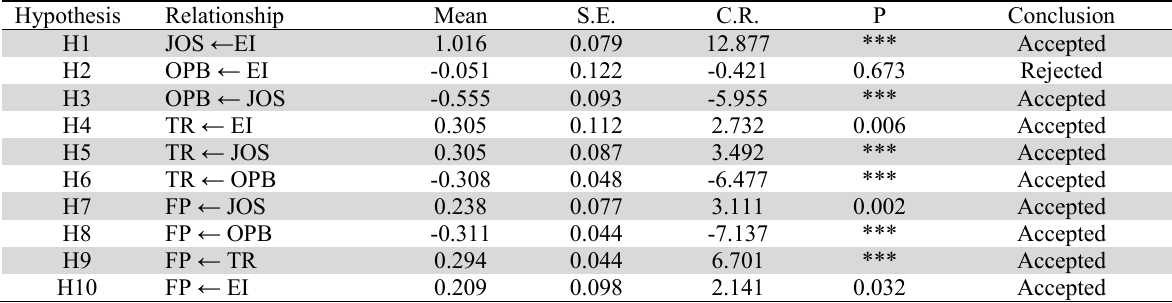
SEM analysis results for the relationships in the